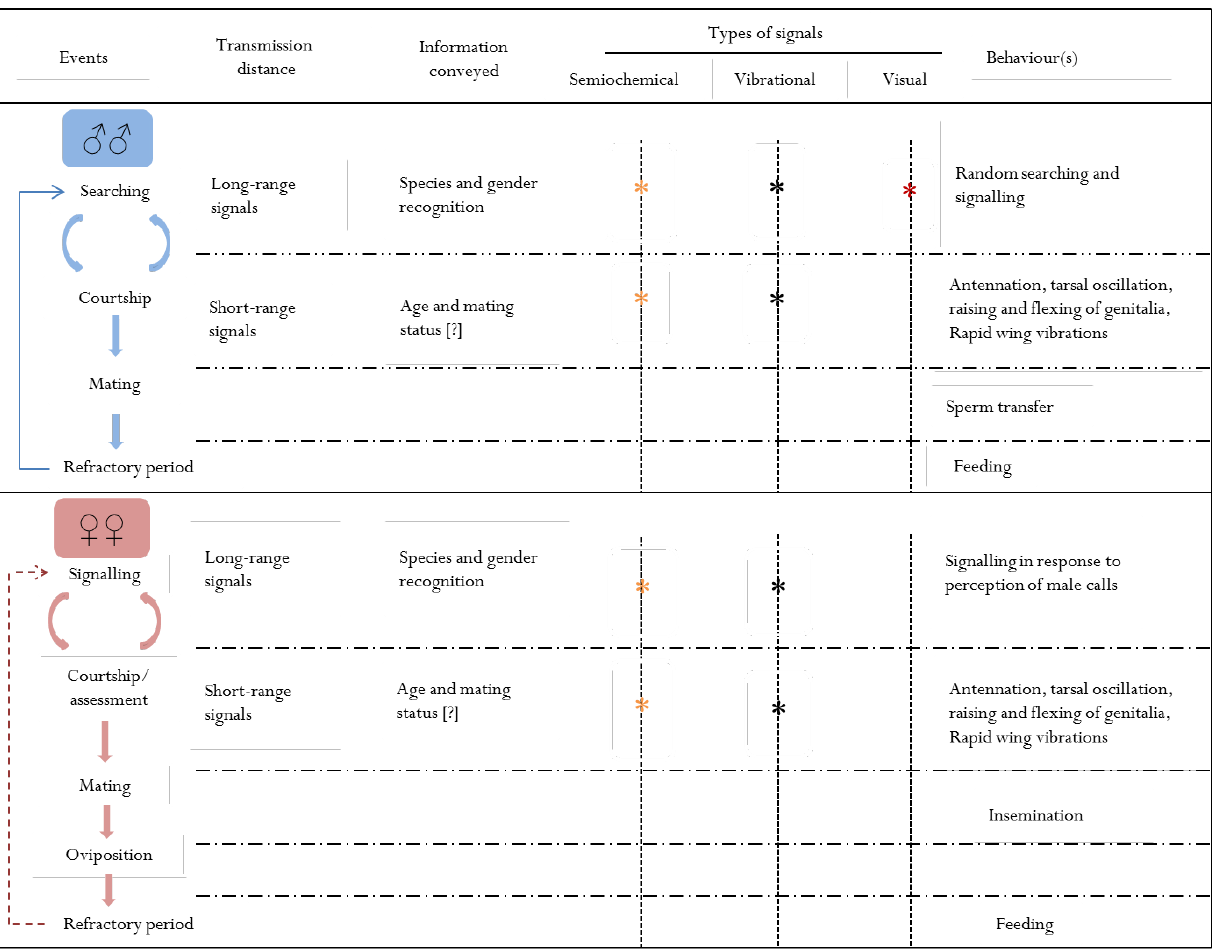
Figure 2. Generalised schema of behaviours from mate location through to mating and the refractory period for male and female psyllids, respectively. Key: * = signal studied, but role and transmission distance remains unclear; * = signal studied and believed to play a role in both mate finding and courtship; * = putative signal; [?] = probable information conveyed. The dotted arrow in the schema for females indicates that some species may mate only